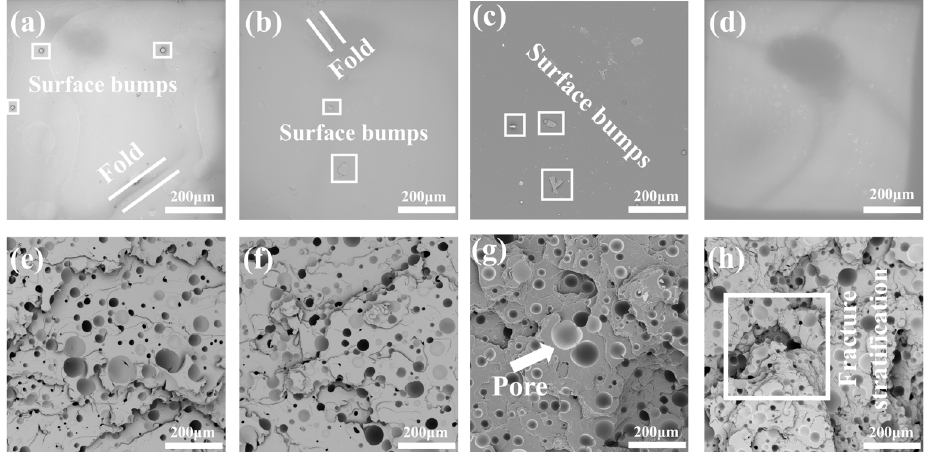
Figure 8. SEM for the front surface of polyurea fracture at different temperature under the same pressures: ( a ) 55 ◦ C; ( b ) 63 ◦ C; ( c ) 70 ◦ C; and ( d ) 80 ◦ C. SEM after the cross-section of polyurea fracture at different temperature under the same pressures: ( e ) 55 ◦ C; ( f ) 63 ◦ C; ( g ) 70 ◦ C; and ( h ) 80 ◦